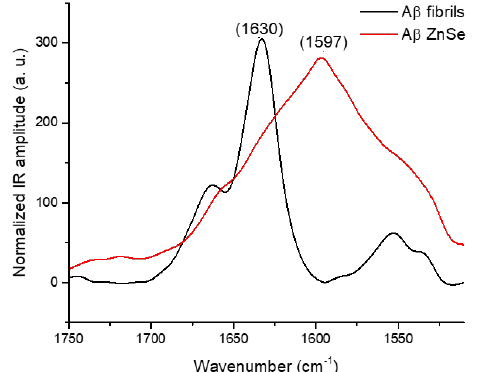
Figure 5. AFM-IR spectra of the A β di ff erent species, normalized on the amide I area for the fibrils and from 1650 and 1550 cm − 1 for A β on ZnSe to obtain a comparable scale. The black curve corresponds to the fibrils on the ZnS prism. The ed curve corresponds to fibrils (from the same batch) deposited on the ZnSe prism that changed their structure to amorphous aggregate. The topography of the di ff erent species is available in Figure 4a,b